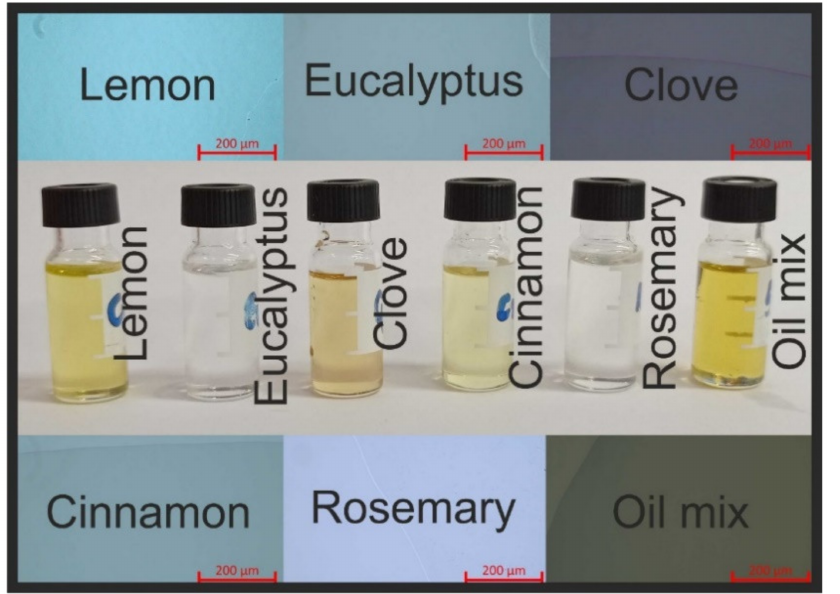
Figure 4. Camera image (in the middle) and microscopic images (around) of the EOs and the oil mix. L * a * b * test results (see Figure 5) showed that lemon and cinnamon oils with positive values for b * and negative values for a * had a yellow-green color. Clove oil, with the highest positive value for b *, had more yellow intensity. Color components of eucalyptus and rosemary oils are in the center of the color space diagram, showing that these oils are colorless. The most intensive color was observed for the oil mix, with a green tendency (positive a *). Color changes help to evaluate the quality of oil as well as EOs. What is more, color changes of EOs might be applied as an identifier of food product quality, such as of lettuce [43]. In Figure 6, differences in the refractive index (RI) are seen. For transparent oils, such as eucalyptus and rosemary, the RI was 1.462 and 1.468, respectively. A very similar RI was determined for lemon oil (1.474). The highest RI was 1.590, for cinnamon, which was a value similar to the previously obtained 1.50 ± 0.02 and presented in [44]. An almost average RI was determined for the oil mix: 1.555 measured (arithmetic average from all oils: 1.506).